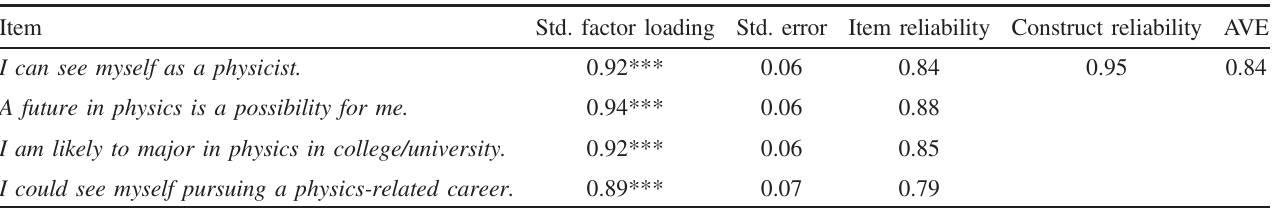
TABLE II. CFA results for Study 2.